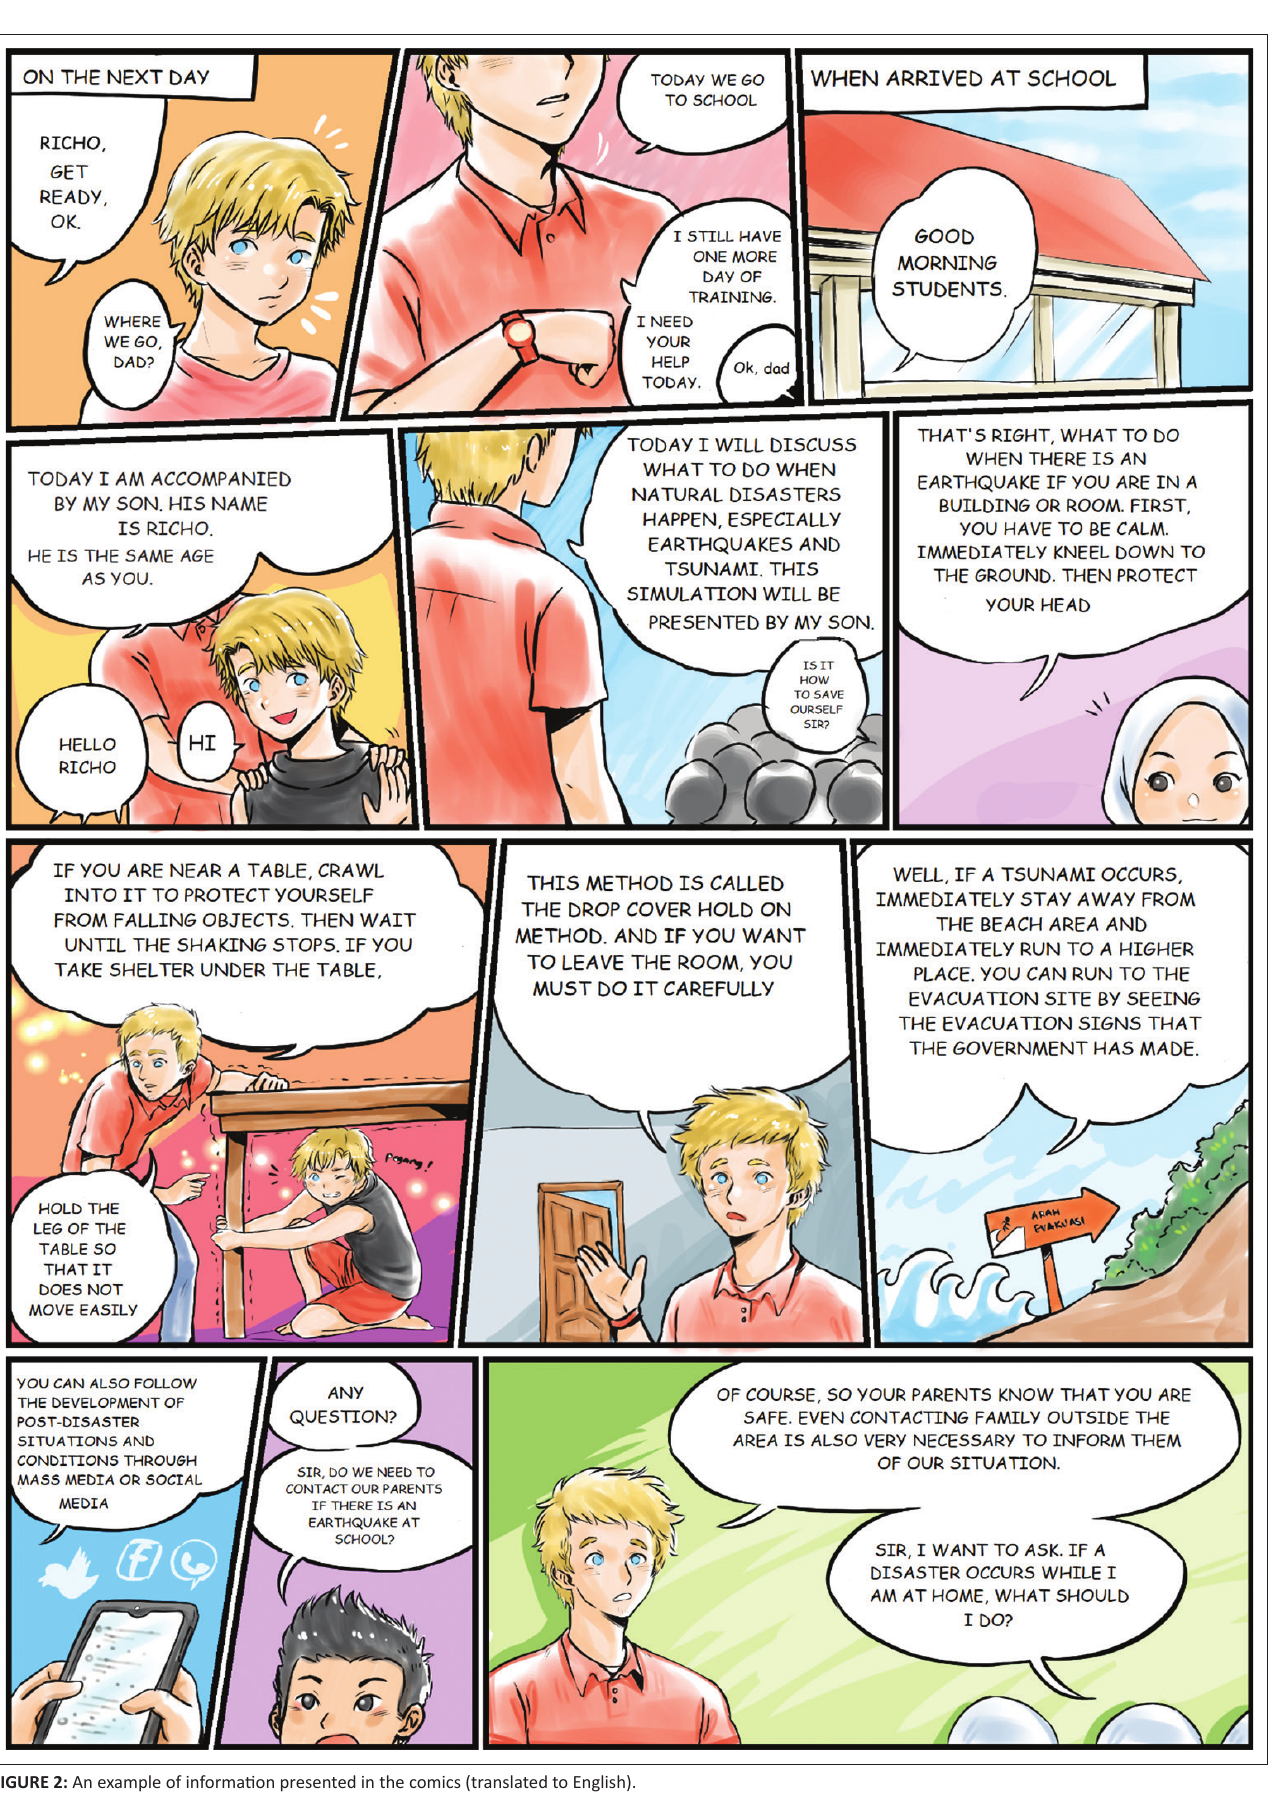
FIGURE 2: An example of information presented in the comics (translated to